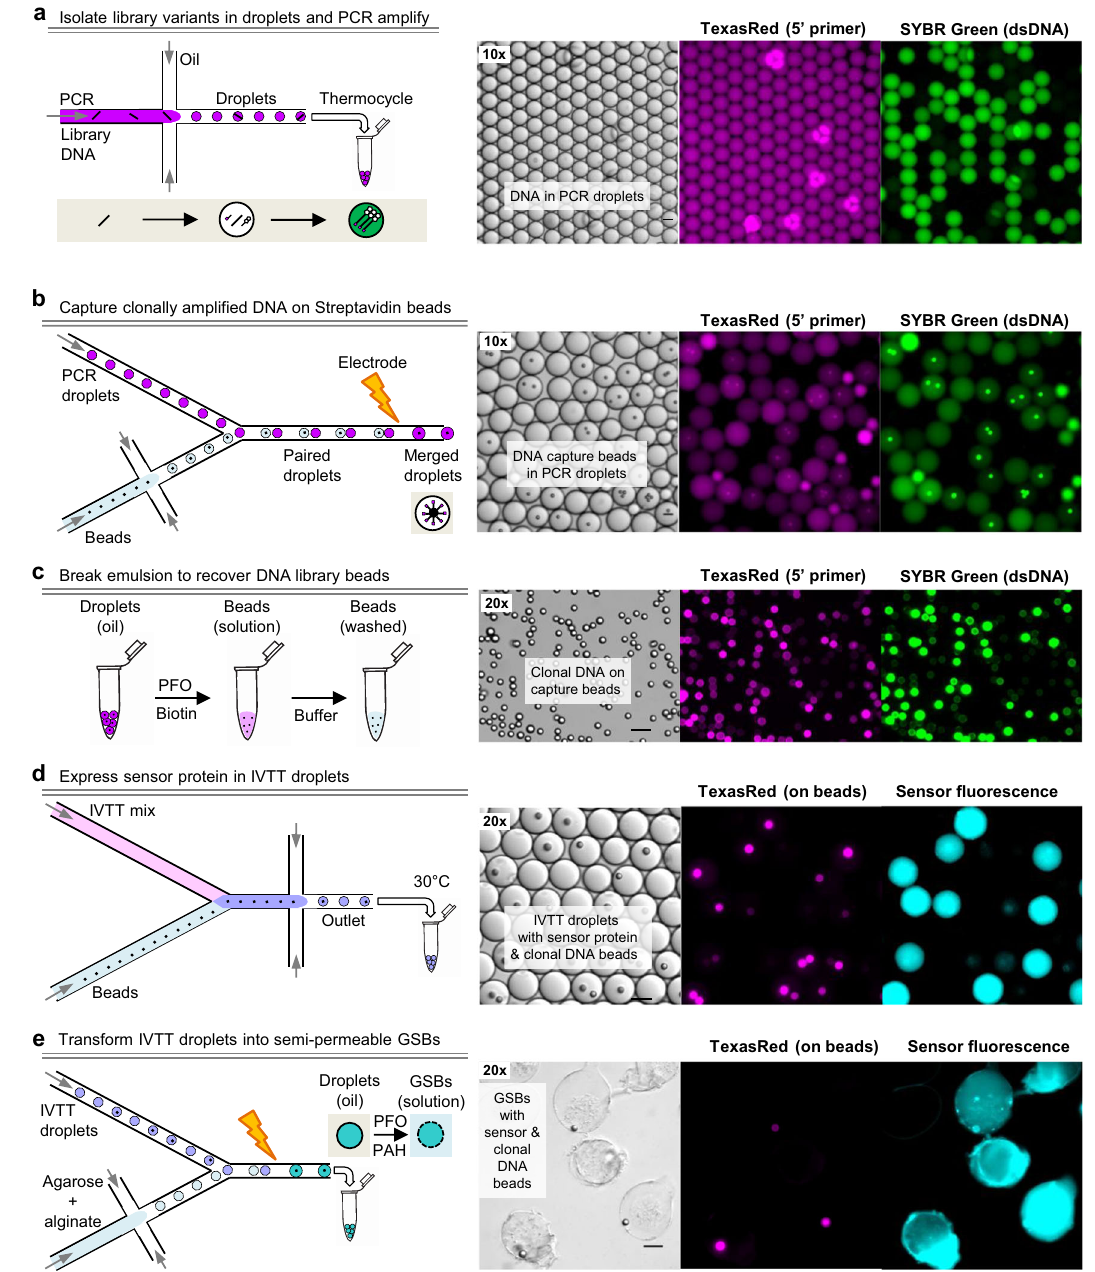
Fig. 2 Micro fl uidic work fl ow to generate a biosensor library in GSBs. a Dilute library DNA is mixed with hot-start PCR reagents and emulsi fi ed using a micro fl uidic droplet generator, such that most droplets contain either 1 or 0 copies of DNA. All droplets have 5 ’ -TexasRed-Forward (stick with pink dot) and 5 ’ -Biotin-Reverse (stick with open double pentagon) primers, such that amplicons carry a TexasRed tag on the sense strand and a biotin tag on the antisense strand. Droplets with ampli fi ed DNA will stain with SYBR Green, added to a diagnostic aliquot of the emulsion. b Biotinylated DNA is captured on streptavidin beads by controlled micro fl uidic merging of PCR droplets with bead-containing droplets. PCR droplets are reinjected into a micro fl uidic device, while a suspension of streptavidin beads is emulsi fi ed on-chip. Pairs of droplets are actively merged (>80% ef fi ciency) as they pass a localized fi eld generated by an electrode (10 kHz, 0.5 kV), at which point the ampli fi ed DNA is captured by the beads. c Addition of per fl uorooctanol (PFO) breaks the emulsion, which separates into an aqueous phase containing the beads and an oil phase. The beads are then washed to eliminate residual unbound DNA. d The library of DNA beads is re-encapsulated in new droplets along with in vitro transcription/translation (IVTT) reagents using a custom micro fl uidic device that combines the two aqueous streams immediately prior to emulsi fi cation, mitigating premature transcription and mRNA cross-contamination. Only droplets containing a DNA bead will express fl uorescent biosensor protein following an overnight incubation at 30 °C. e Finally, IVTT droplets are converted into durable semipermeable GSBs by controlled micro fl uidic merging with a mixture of agarose (gel in sol) and alginate (polyanion), followed by emulsion breakage by PFO in the presence of PAH (polycation). The two polyelectrolytes form a semipermeable shell at the surface of the gel scaffold, trapping proteins and DNA inside the gel but allowing small molecules (<2 kDa) to pass through 17 . Continuous exchange of ligands allows for the collection of full dose-response curves from the biosensor protein encapsulated in each gel during downstream screening. Scale bars represent 20 μ